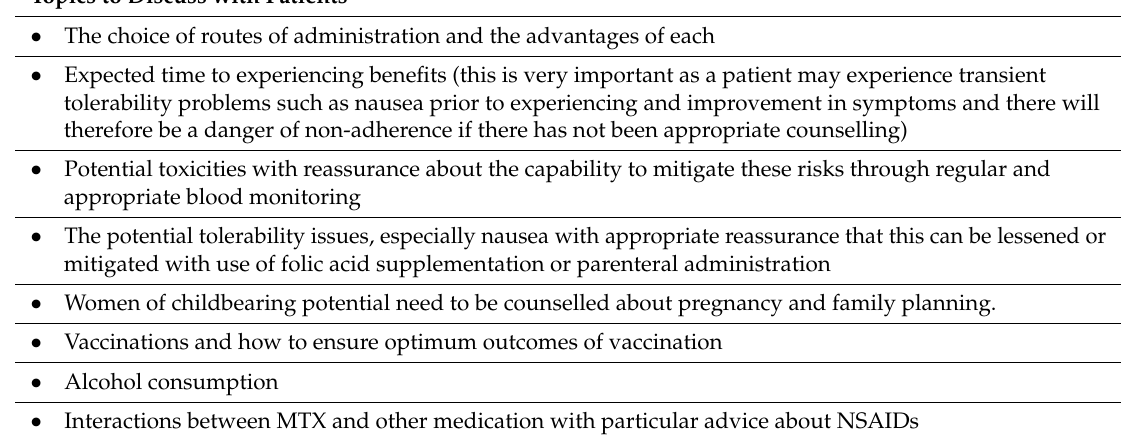
Key points patients will need to be counselled about when rheumatologists adopt a shared decision-making approach to the recommended regime.